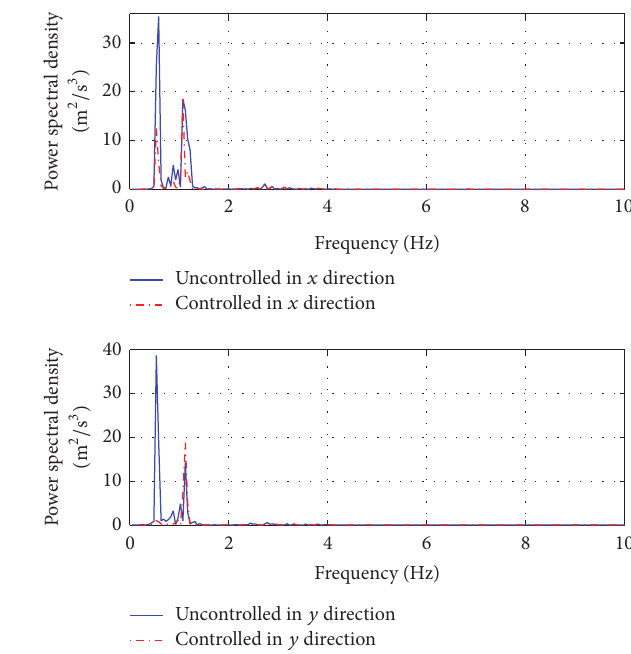
Figure 15: Displacement responses of the tower top under earth- quake.